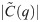
Quefrency domain analysis.The cepstrum, |C˜(q)|, of the 180 μm HDPE scattering particles (blue), κ of riboflavin (magenta) and κ of lactose (red), and the shape of the Gaussian filters, G(q), for each respective material are shown.